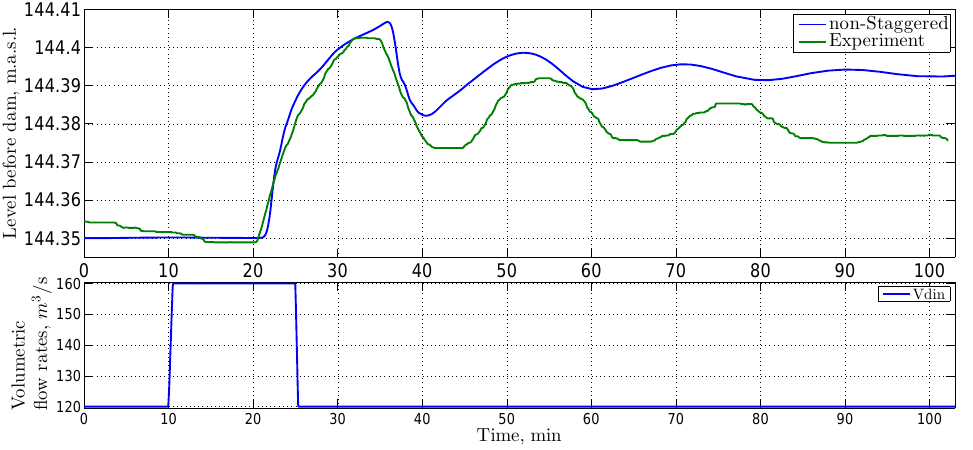
Figure 12: Comparison of the experimental and central upwind scheme results.